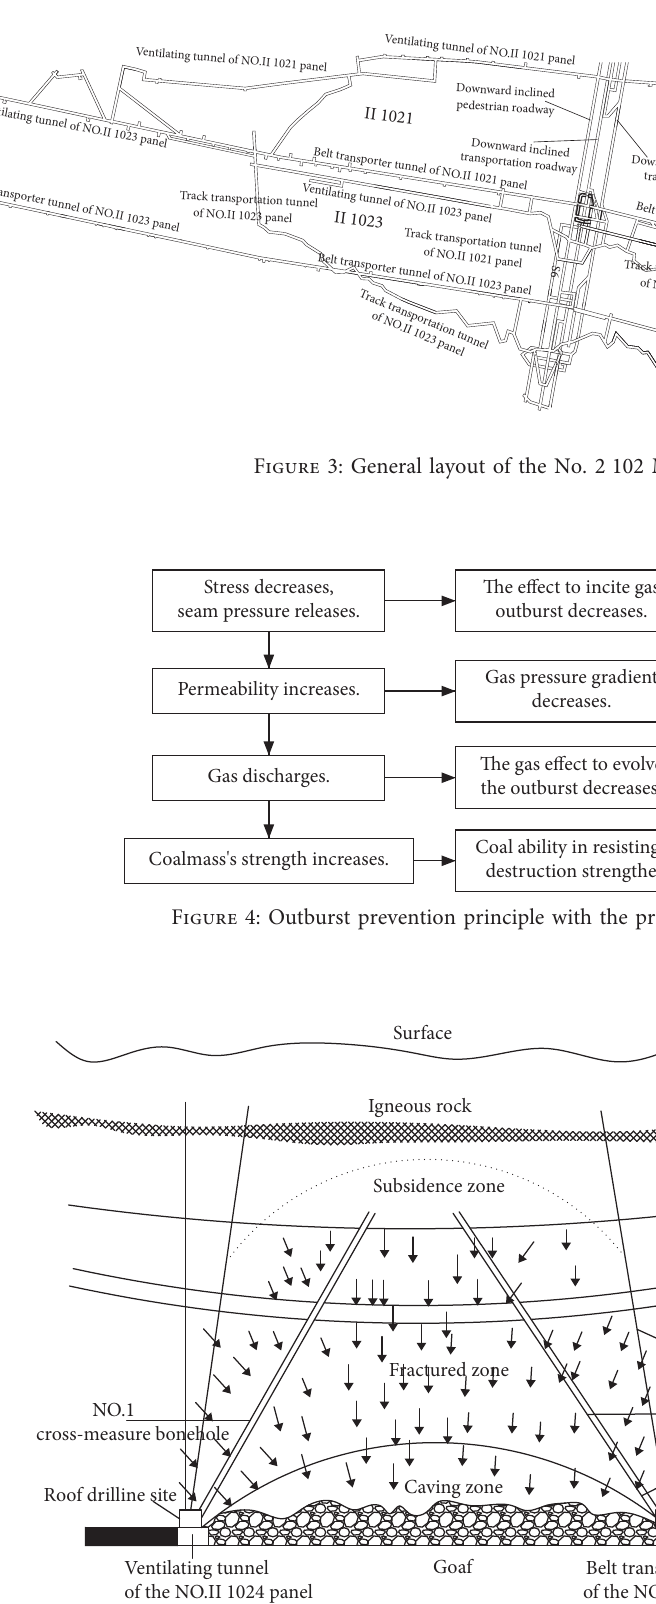
Figure 5: Diagram illustrating principle of gas emission in protected coal seam and gas drainage methods with cross-measure